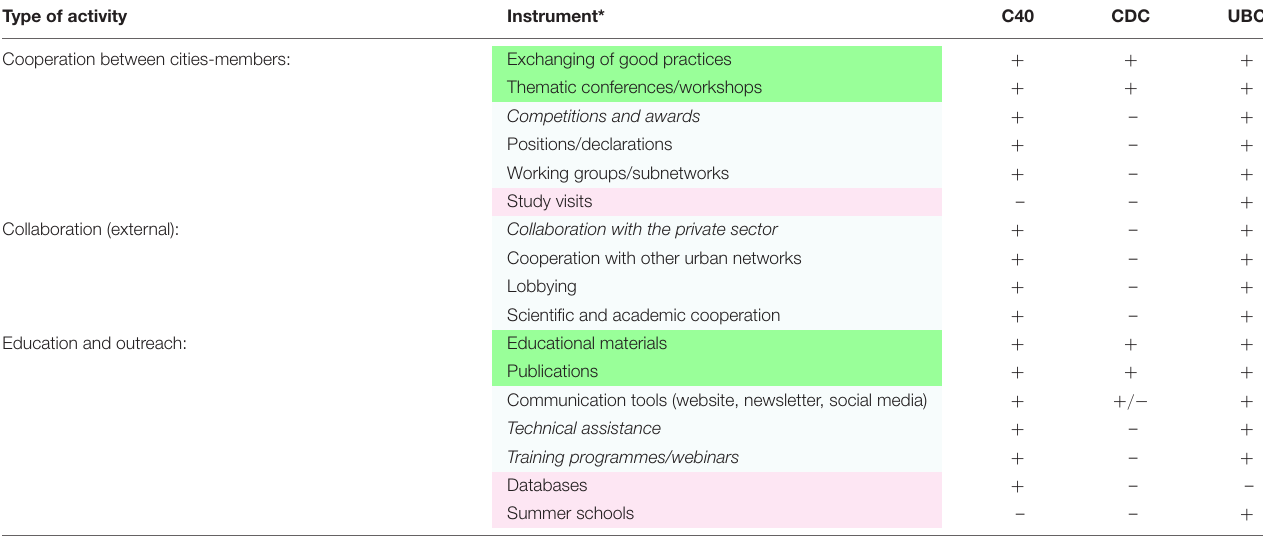
TABLE 7 | Types of activities and applied instruments – data from C40 Cities Climate Leadership Group (C40), Connecting Delta Cities (CDC), and Union of Baltic Cities